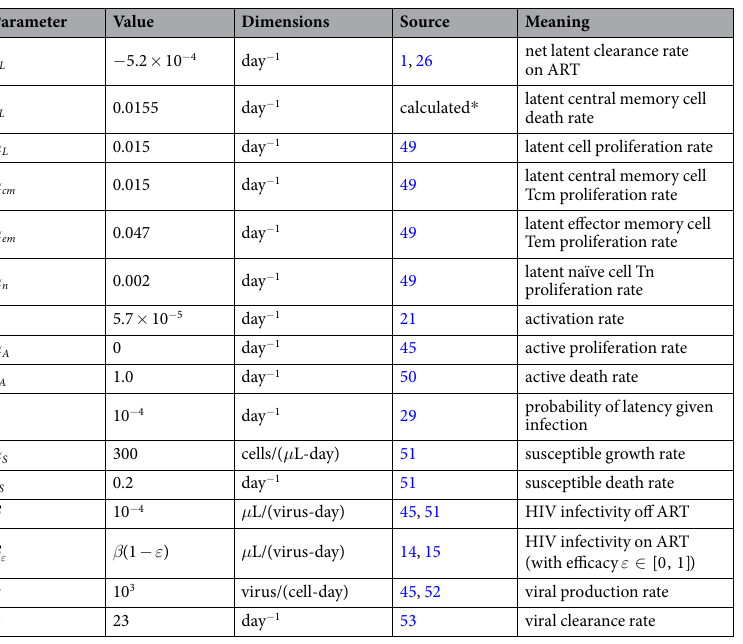
Table 1. Parameters used in the HIV latency model. All cellular rates are for CD4 + T cells. * Death rates for each cell type are calculated using the total clearance as δ i = α i − ξ − θ L with ∈ i L cm em n [ , , , ]